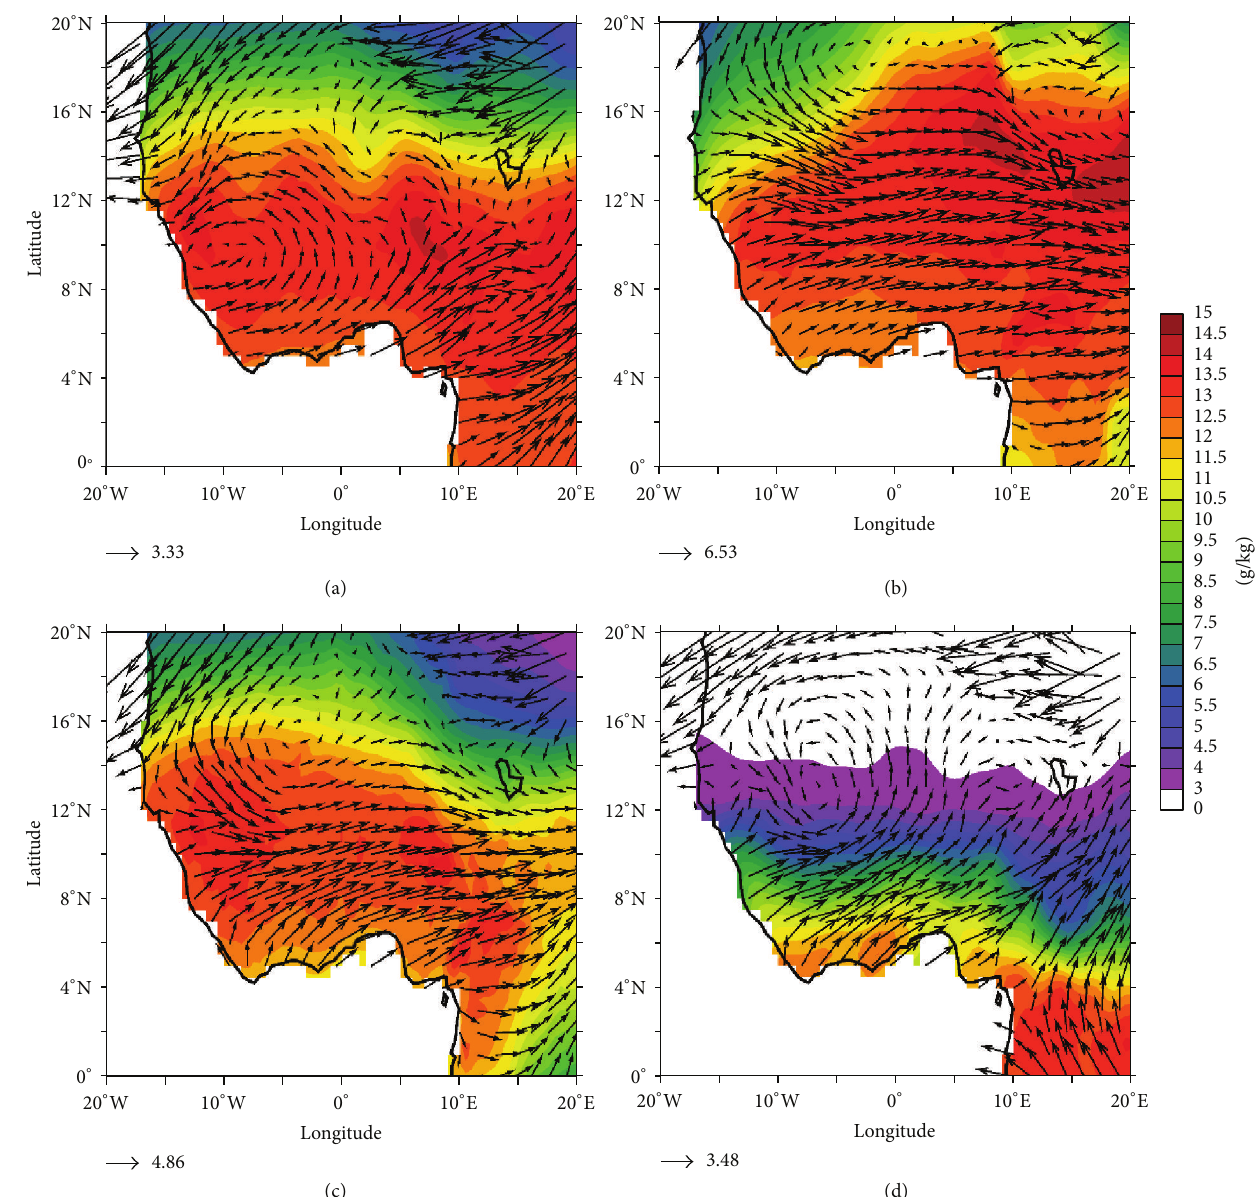
Figure 7: Spatial pattern of mean monthly JJAS 850 mb specific humidity (g/kg) and wind field (m/s) for (a) ERA-Interim, (b) CCLM, (c) RCA, and (d) REMO from 1998 to